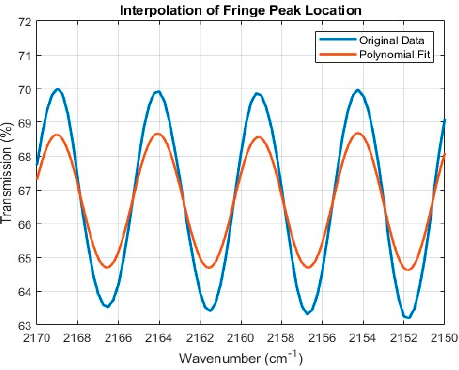
Figure 5. The accuracy of interference fringe peak location measurements is increased by interpolation via a polynomial fit.